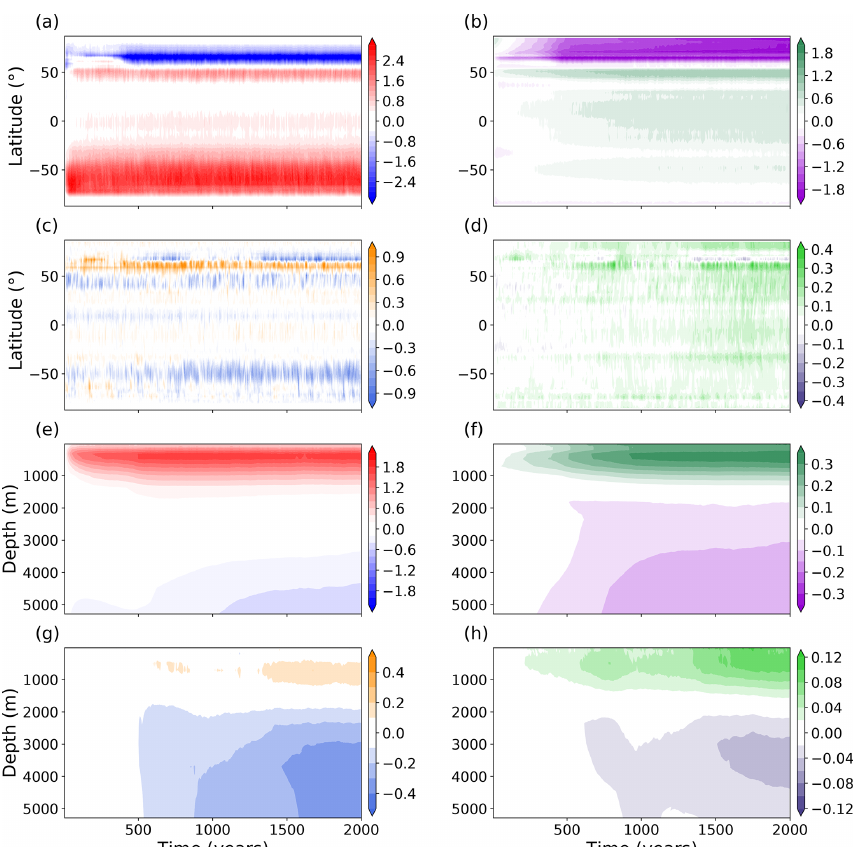
Figure 2. Time–latitude plots of drift in annual mean sea surface (a) temperature ( ◦ C) and (b) salinity (PSU) in the L35 simulation. Differ- ences (L20–L35) in annual mean sea surface (c) temperature ( ◦ C) and (d) salinity (PSU). Time–depth series of global drift in annual mean (e) potential temperature ( ◦ C) and (f) salinity (PSU). Differences (L20–L35) in annual mean (g) potential temperature ( ◦ C) and (h) salinity (PSU). Drift is relative to initial conditions.